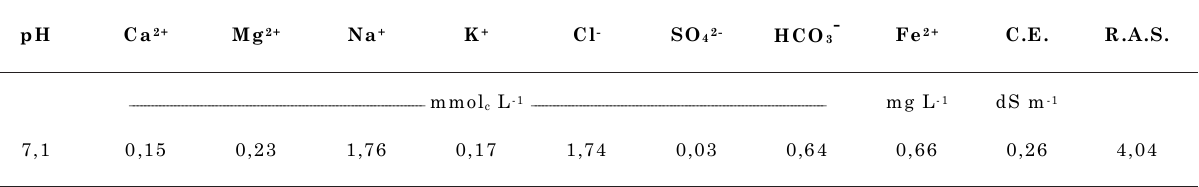
C.E. = condutividade elétrica; R.A.S = razão de adsorção de